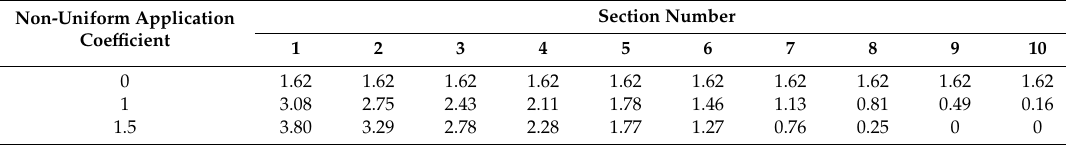
Table 3. Fertilization amount (unit: kg).